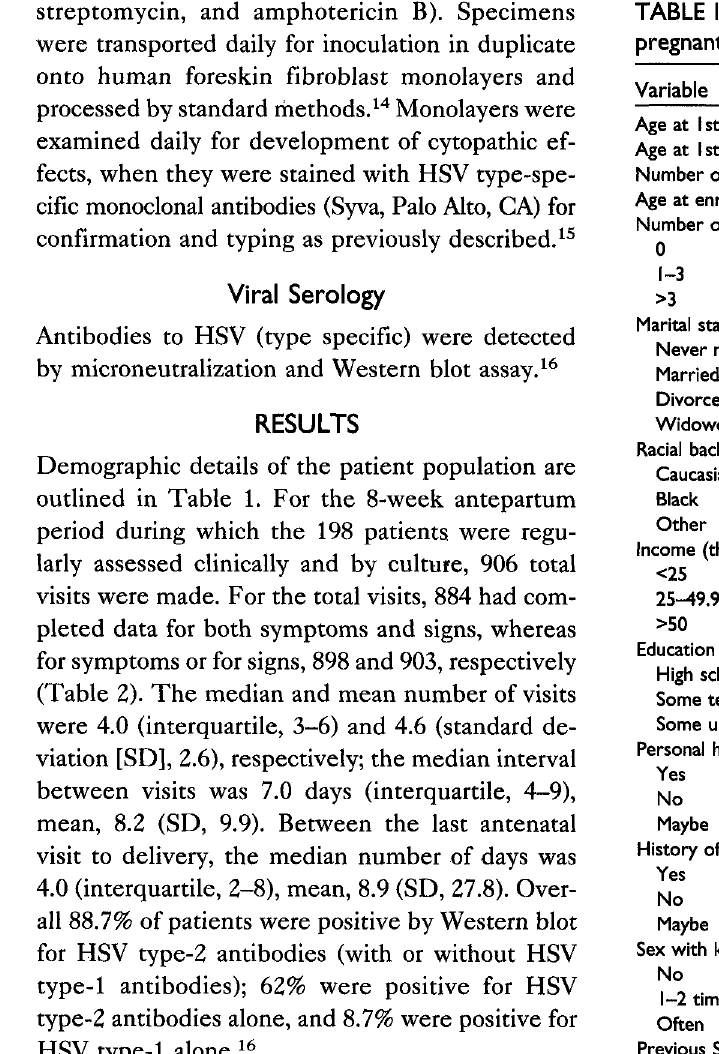
TABLE I. Demographic characteristics of